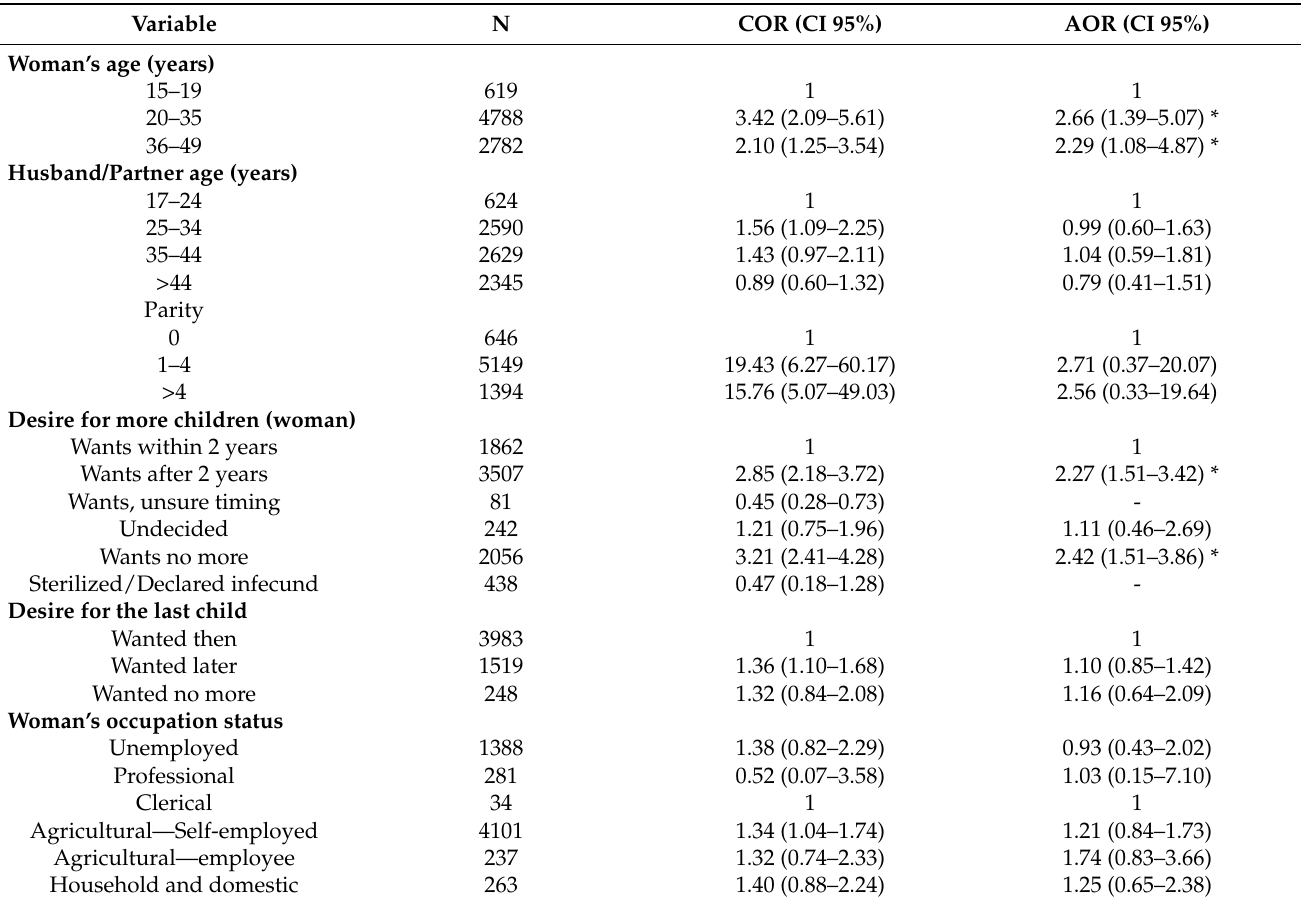
Table 3. Bivariate and multivariate analyses showing odds ratio for factors associated with the use of LARC (N =